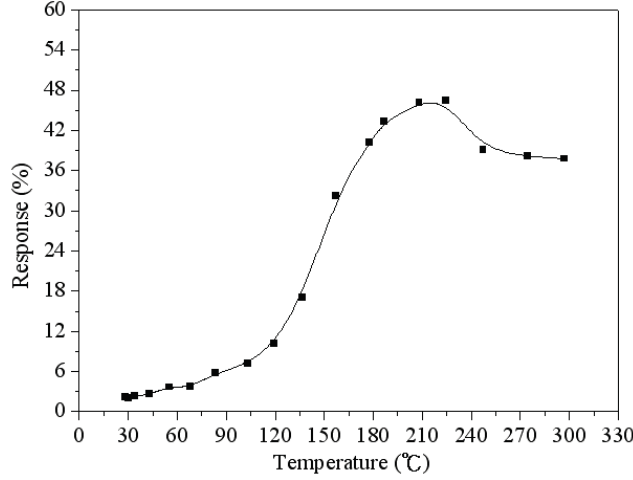
Figure 9. Response of the ethanol sensor at 3 ppm ethanol.